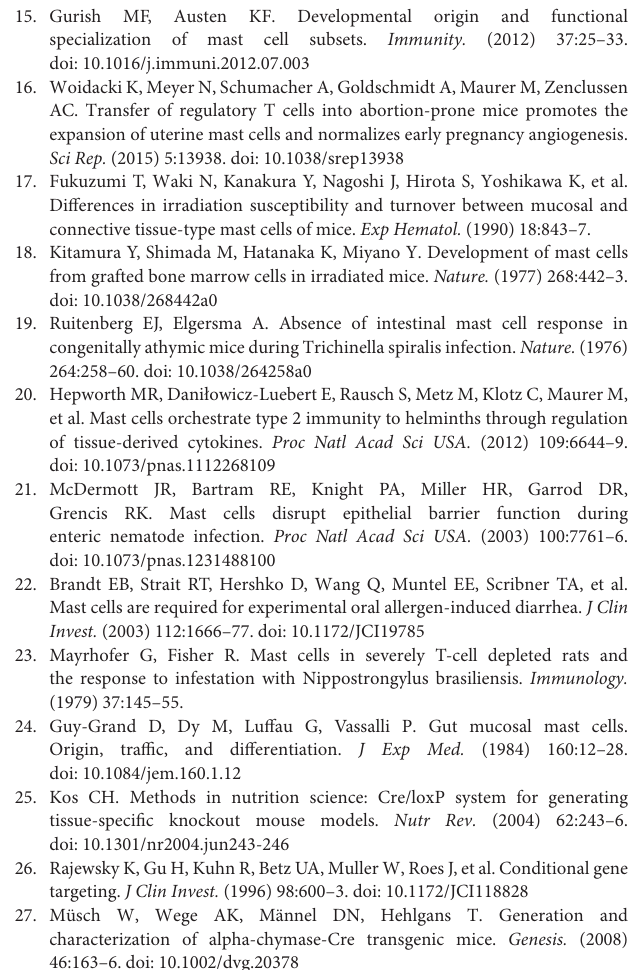
Figure S1 | Chm-Cre; Mcl1 fl / fl mice exhibit no differences in the analyzed placental parameters comparing to Chm-Cre; Mcl1 + / + mice. (A) Placental weight of Chm-Cre; Mcl-1 + / + (mice n = 4, placentas n = 21) and Chm-Cre; Mcl-1 fl / fl (mice n = 5, placentas n = 34) females paired with Balb/c males at gd10. (B) Number of implantations at gd5 or gd10, abortions, and abortion rate at gd10 from Chm-Cre; Mcl-1 + / + ( n = 3–4) and Chm-Cre; Mcl-1 fl / fl ( n = 3–5) females paired with Balb/c males at gd10. Results are presented as individual values ± median. (C) Representative bicorneal uteri of Chm-Cre; Mcl-1 + / + and Chm-Cre; Mcl-1 fl / fl mice at gd5 or gd10. (D) SA wall thickness and SA wall-to-lumen ratio from 3 to 9 SAs per mice of Balb/c-paired Chm-Cre; Mcl-1 + / + ( n = 4) and Chm-Cre; Mcl-1 fl / fl ( n = 5) females at gd10. Statistical differences were analyzed with the Mann–Whitney test. gd, gestation day; SA, spiral